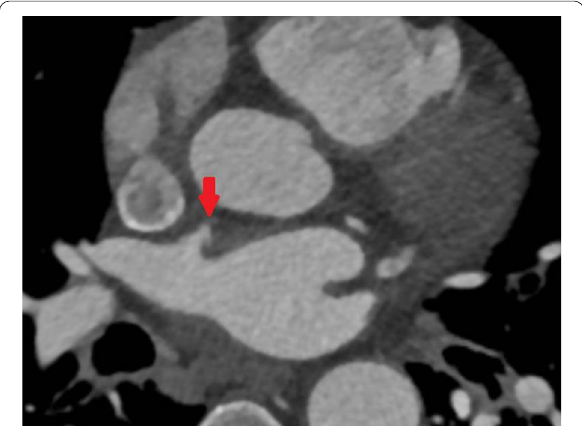
Fig. 3 Accessory appendage is observed in the anterosuperior localization of the left atrium